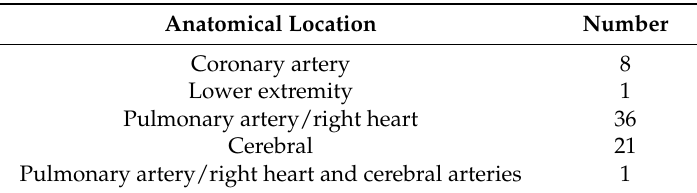
Table 4. Anatomic location of air